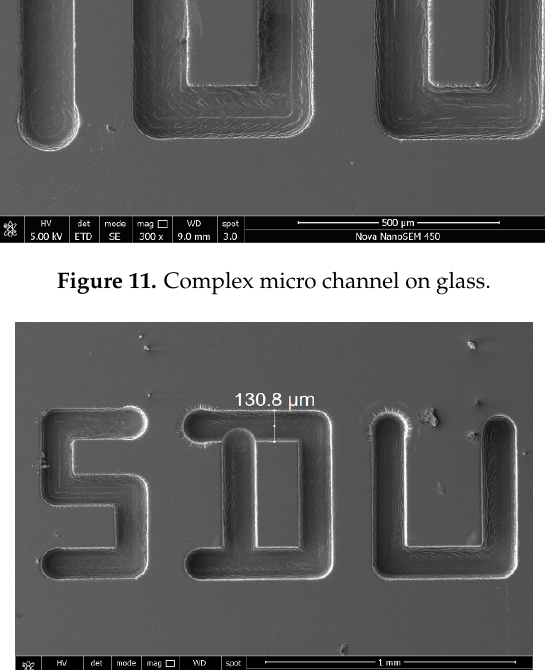
Figure 12. The abbreviation of the university name on glass.